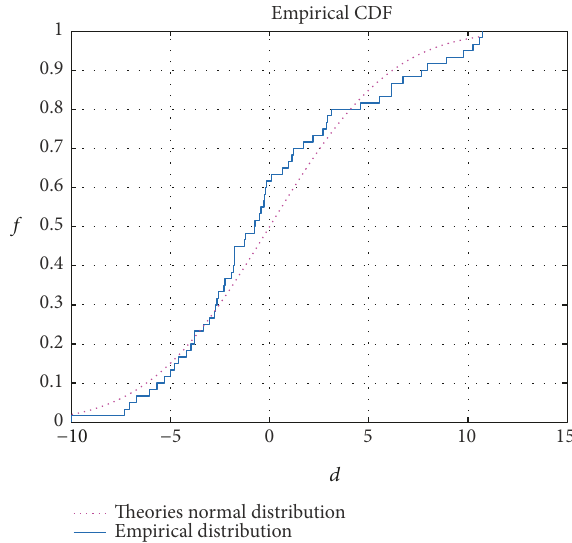
Figure 8: Empirical distribution and theories normal